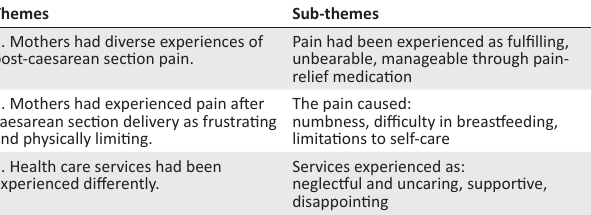
TABLE 2: Themes and subthemes of the study. Themes